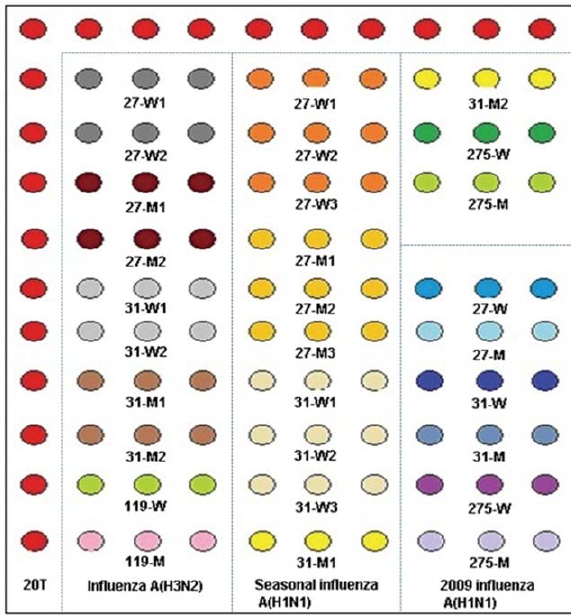
Figure 1. Microarray layout. Capture probes were spotted in triplicate in rows and were grouped in three areas by subtypes. The sequence of 20T was repeated 20 times for quality control and indicated the situations of capture probes.